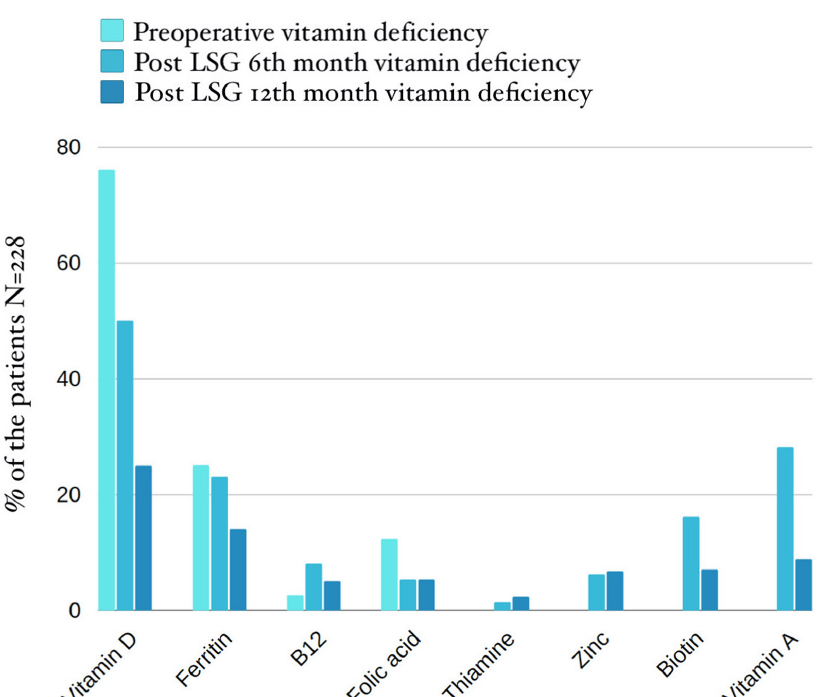
Figure 1. Pre- and post-LSG vitamin deficiencies. LSG, laparoscopic sleeve